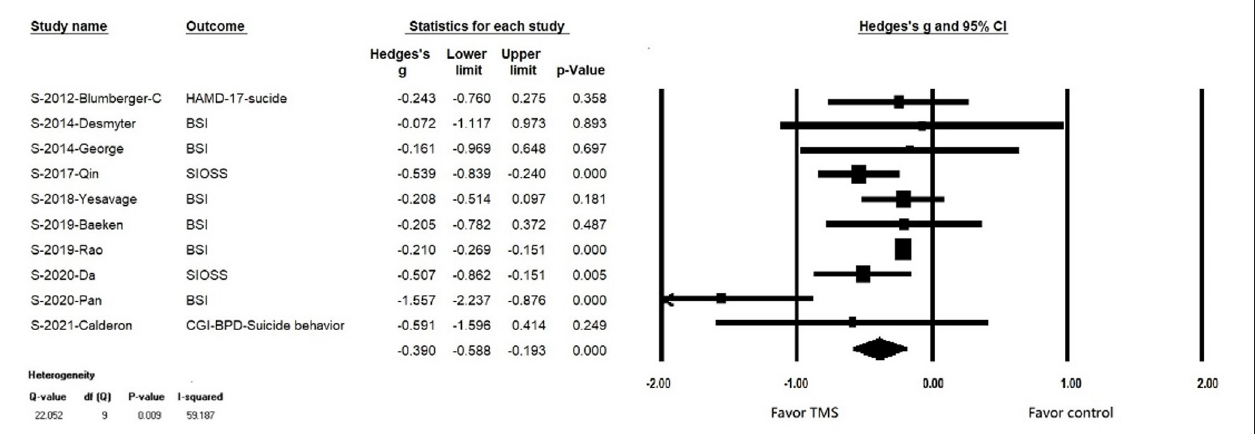
FIGURE 2 | Forest plot of meta-analysis of improvement of suicidal ideation in patients receiving repetitive transcranial magnetic stimulation treatment and in those with control treatment.